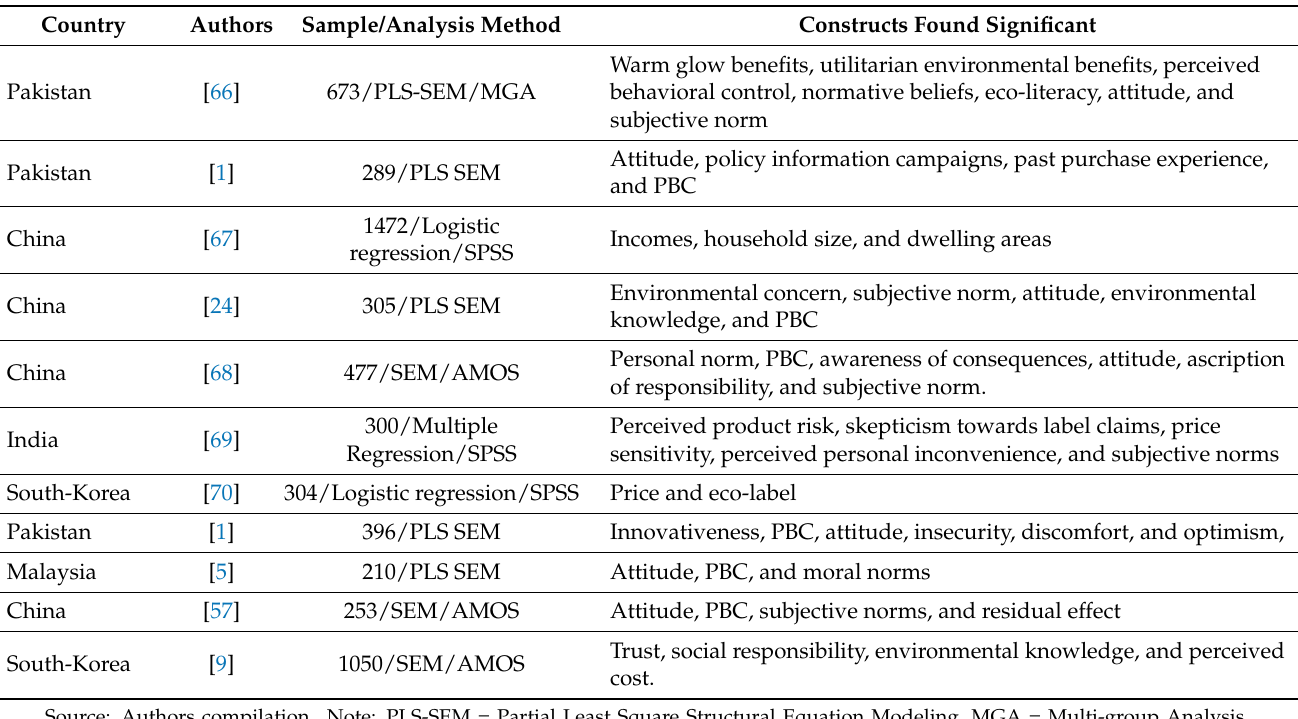
Table 1. The Buying Intention of Energy-Efficient Appliances in Asian